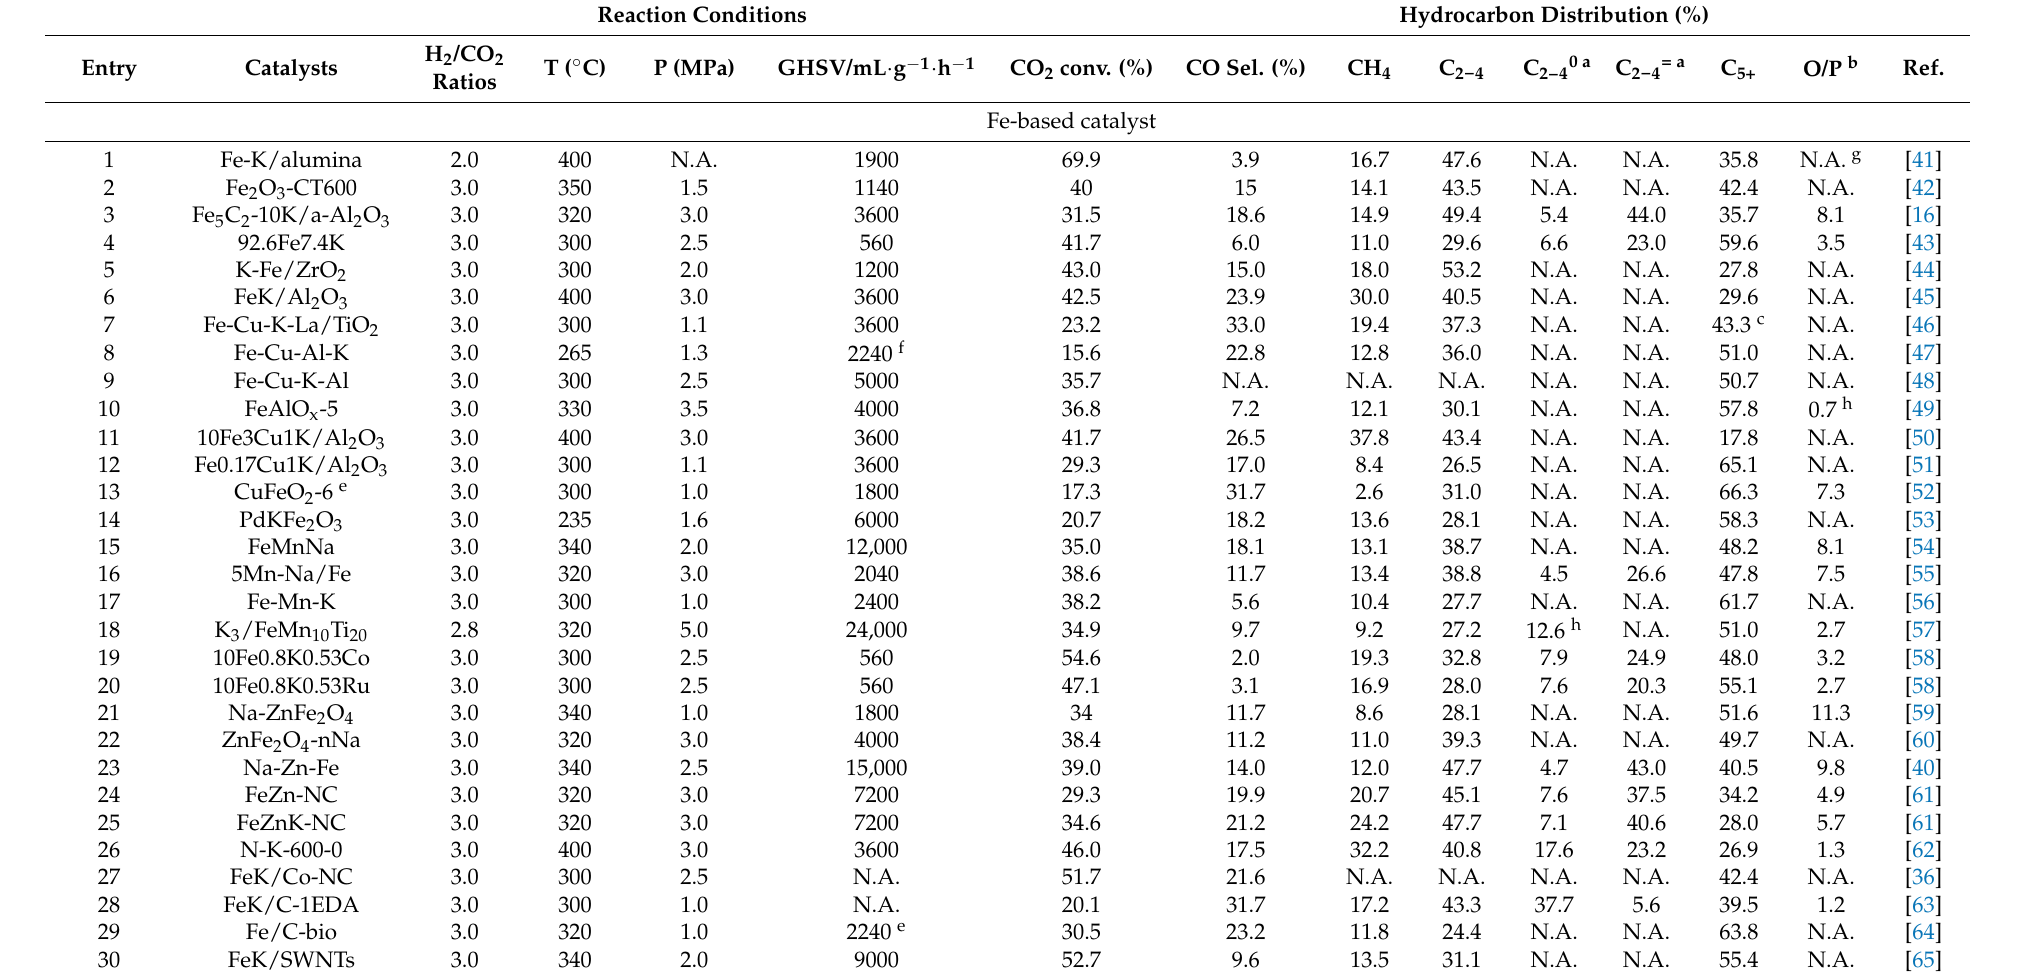
Table 1. Representative catalysts and their performance for the direct hydrogenation of CO 2 to liquid